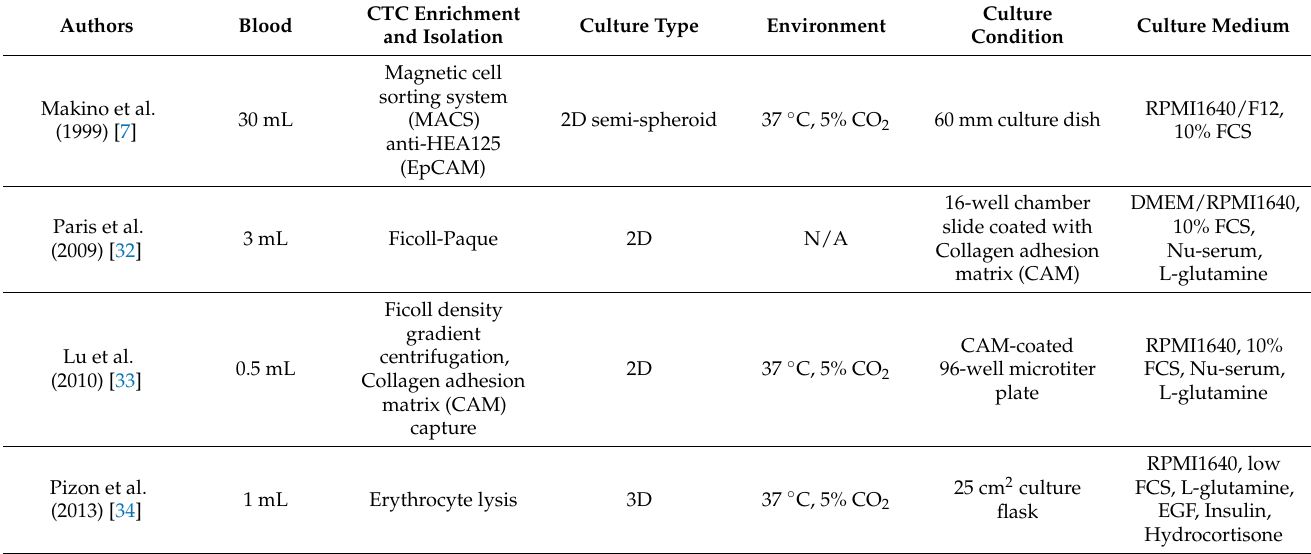
Table 4. Protocol for the short-term